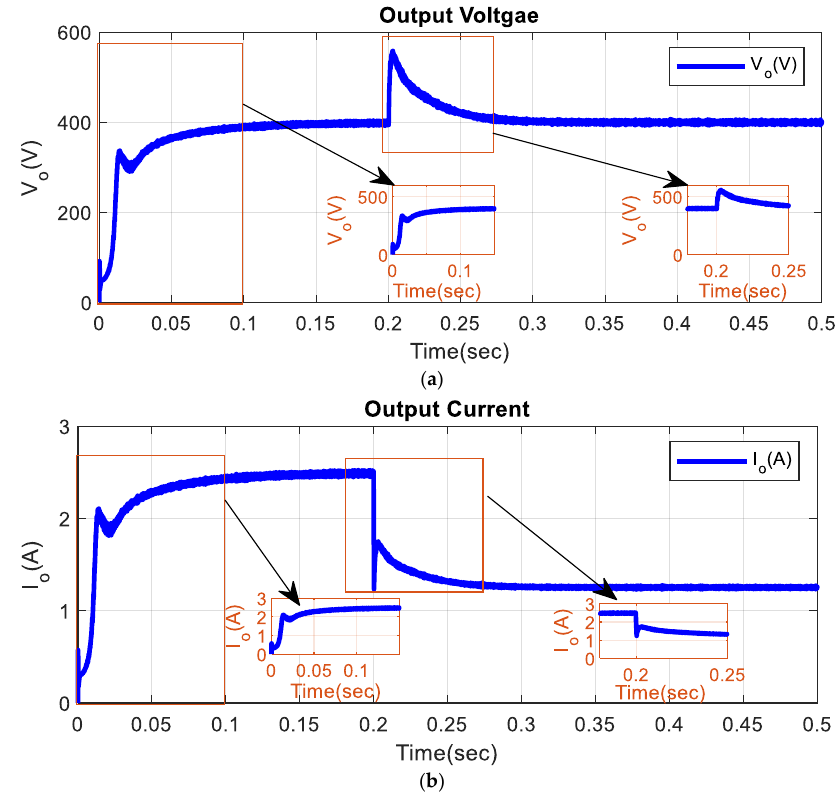
Figure 15. Load parameters during load change from 1000 W to 500